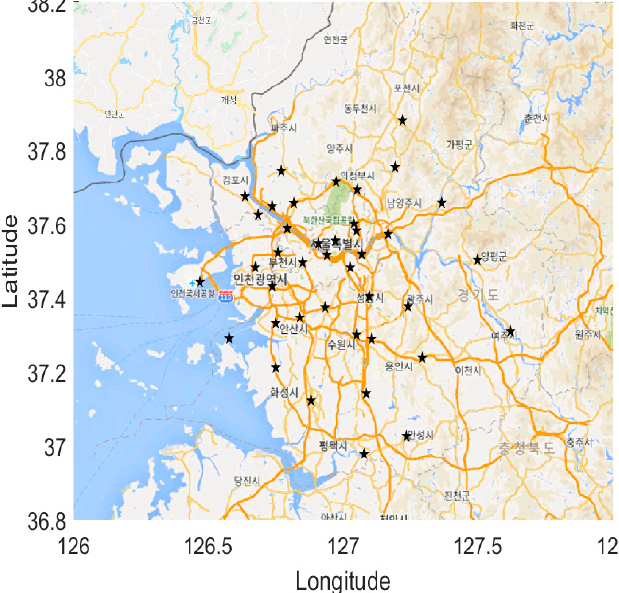
Figure 6. Location of repositioned vertiports.